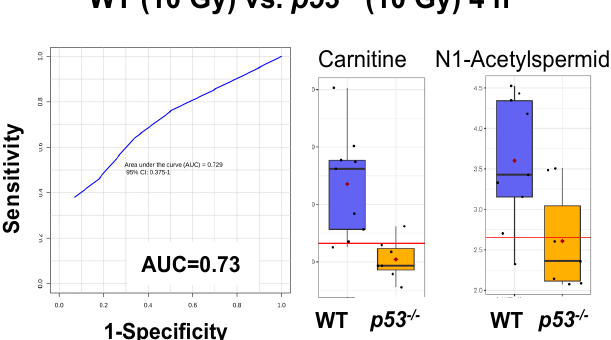
Figure 4. Receiver operating characteristic analysis of wild-type (WT) mice and p53 − / − mice. The highest specificity and sensitivity was obtained for carnitine and N1-acetylspermidine grouped at 4 h for the equitoxic dose (8 Gy) (area under the curve (AUC) = 0.91), with box and whisker plots illustrating higher concentration in WT vs. p53 − / − mice urine post-irradiation. Classification performance was fair for the equidose (10 Gy) (AUC = 0.73).